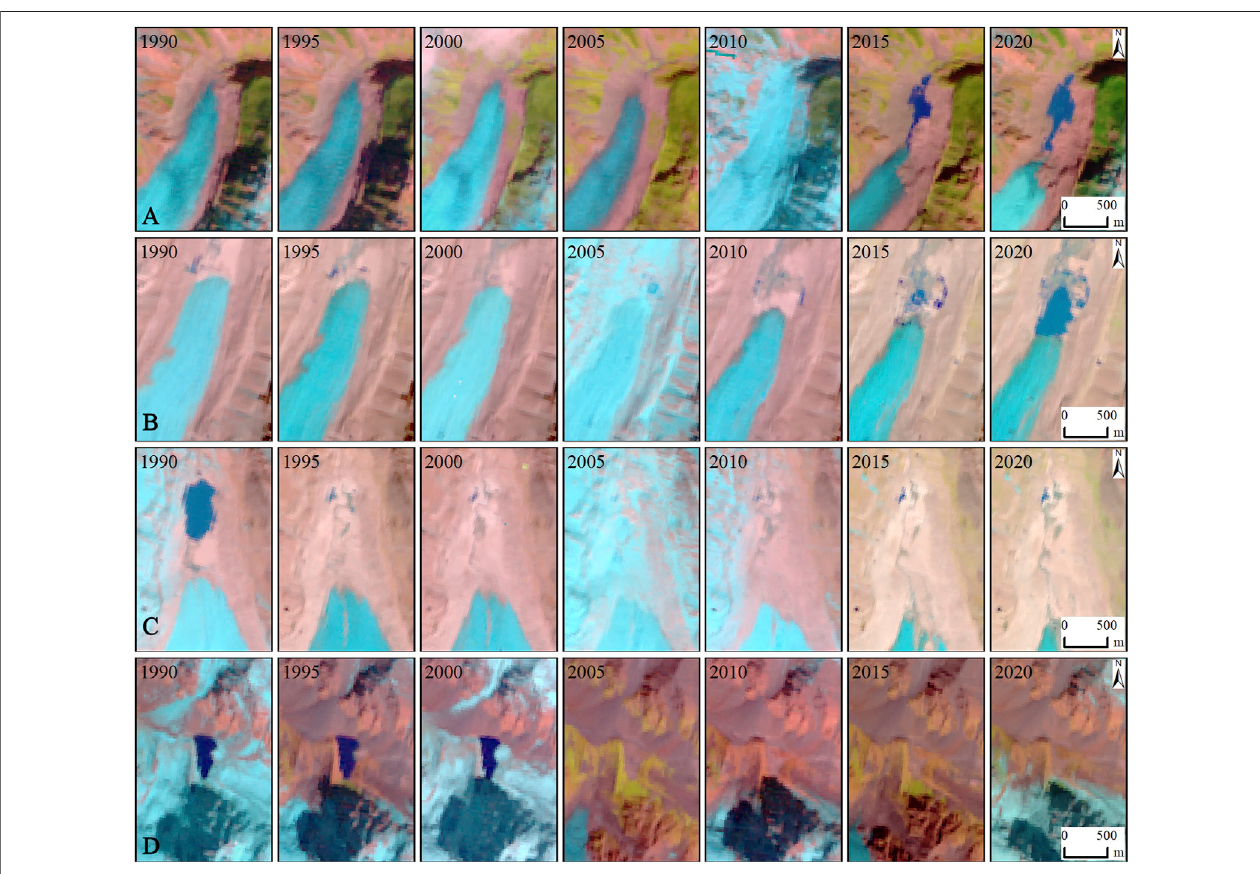
FIGURE 7 | (A , B) Examples of new glacial lake, (C , D) examples of vanished glacial lake.